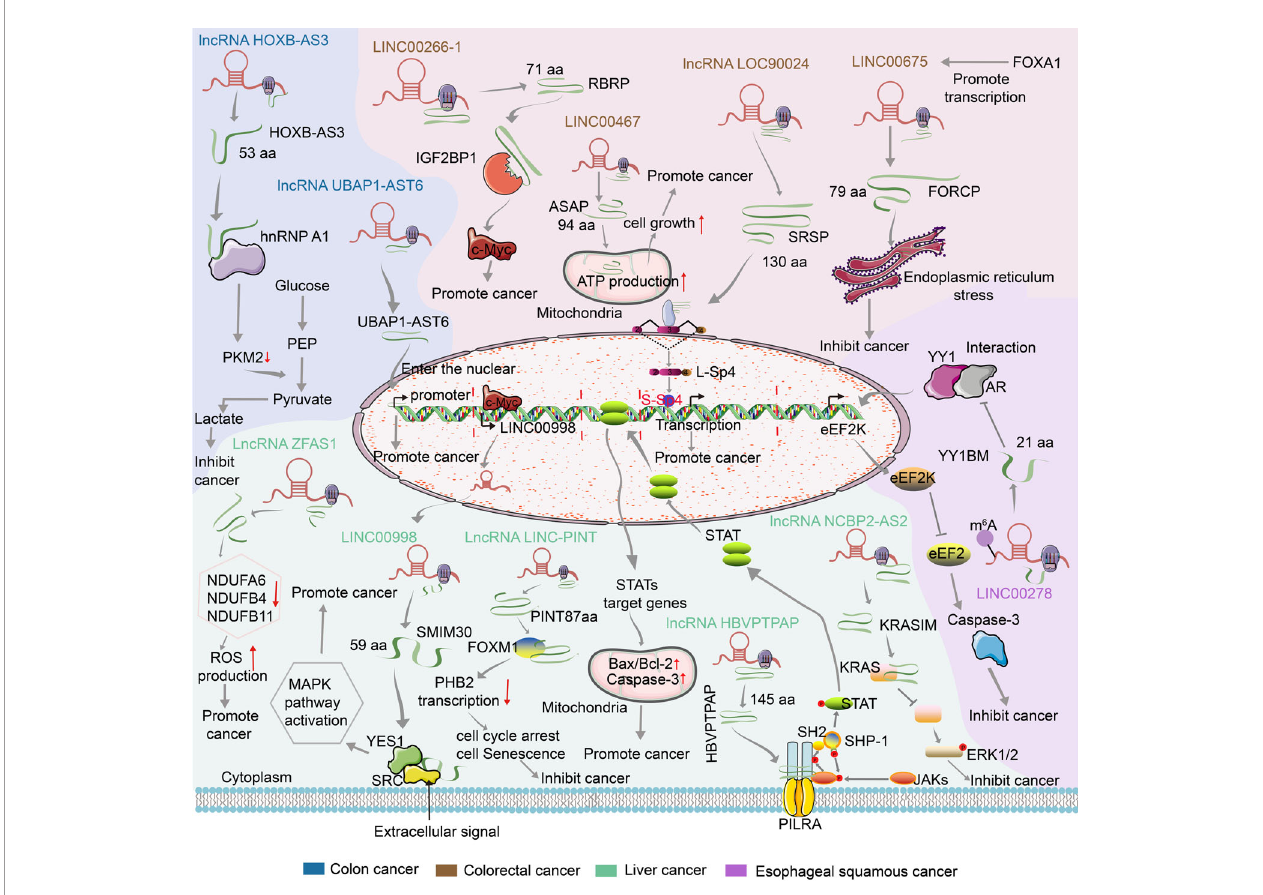
FIGURE 2 | Mechanism of action of lncRNA encoded small peptides in gastrointestinal